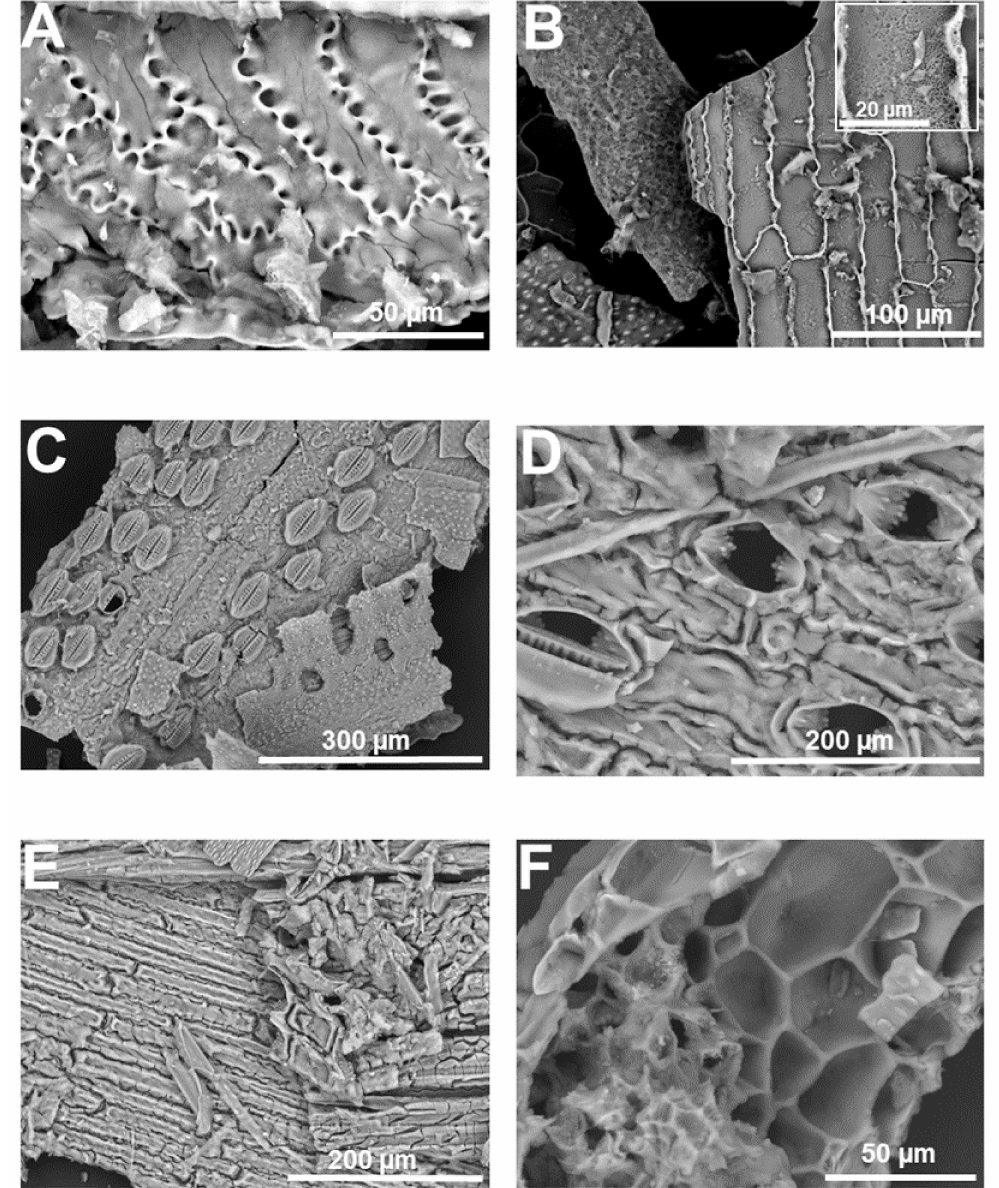
Figure 3. SEM images (topographic contrast) of silica extracted from giant horsetail’s stem. ( A ) Jigsaw-puzzle-like epidermal cells with interdigitated lobes. ( B ) Epidermal cells with undulating walls showing a porous siliceous structure. Inset: detail of the porous texture of the extracted silica. ( C ) Stomata with very fine cellular details of the radiating ribs and sunken stomata among silicified papillae on the stem surface. ( D ) Fine siliceous replica of stomata pores, with details of silicified projections of the outer ledge. ( E ) Epidermal cells and fibrous material extracted from giant horsetail’s stem. ( F ) Probable parenchyma cells. Images were taken using a HITACHI TM3000 TableTop scanning electron